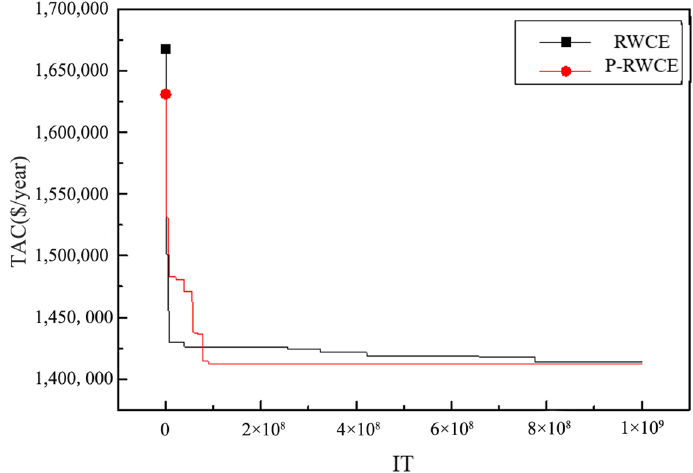
Figure 3. TAC curve of the participatory evolution strategy for streams.